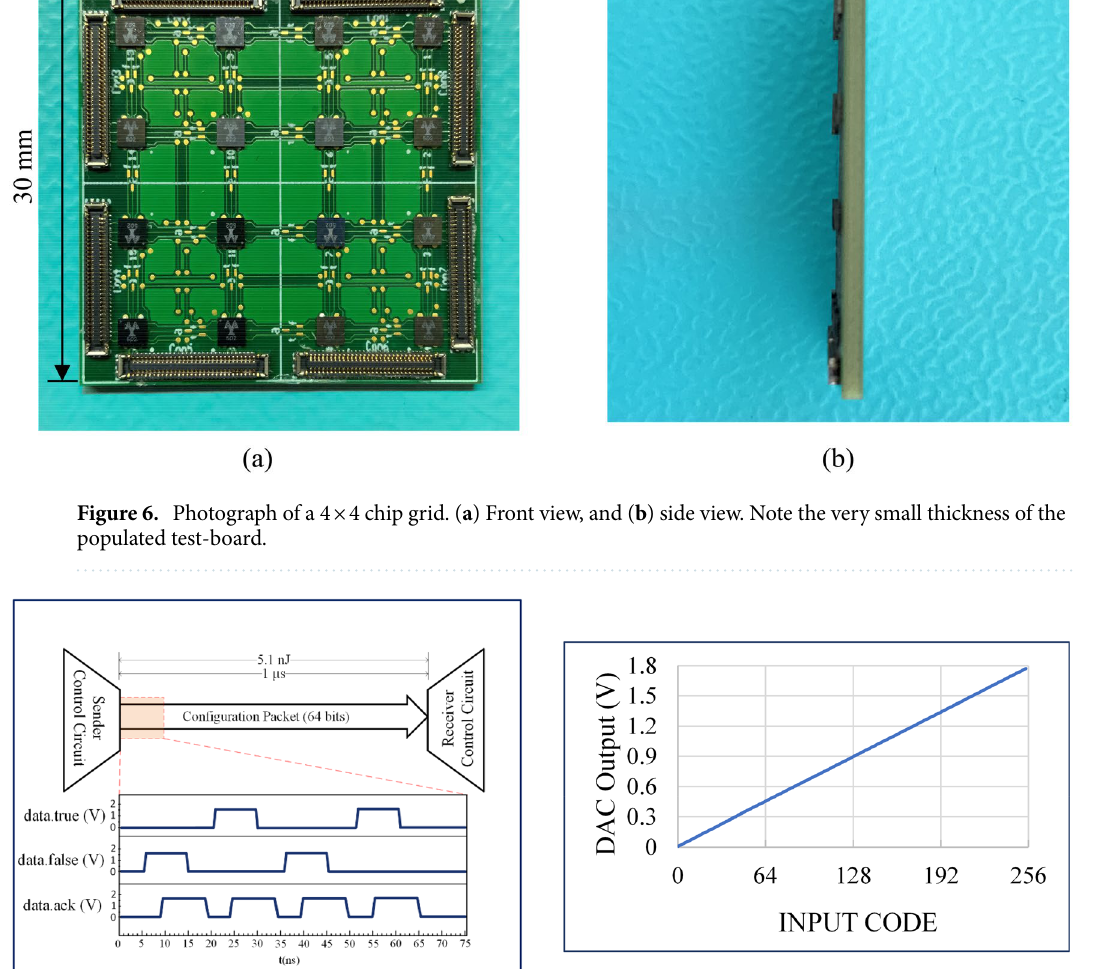
the circuits, the ASIC’s configuration time is not dependent on the data packet content i.e. the cycle time is inde- pendent of the binary sequence transmitted or received. The average configuration time per chip is measured to